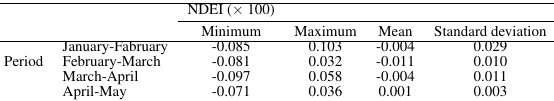
Table 1. Normalized difference elevation index (NDEI) statistics.